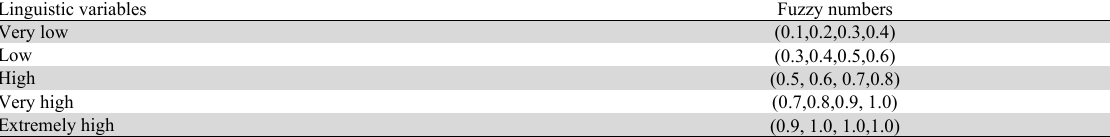
Linguistic terms and corresponding fuzzy numbers for each measure Linguistic variables